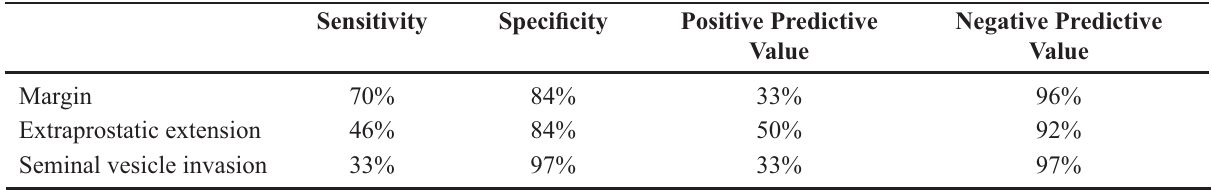
Table 2 – Statistics for positive margin, extraprostatic extension and seminal vesicle